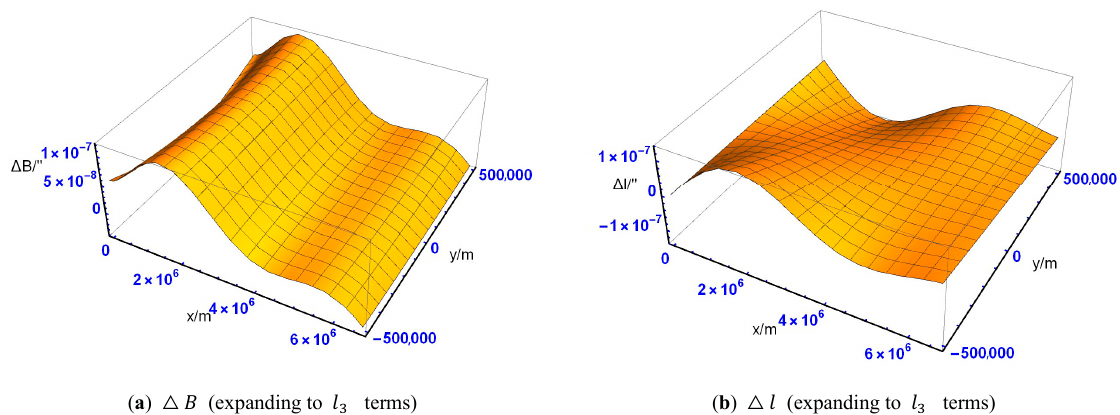
Figure 19. The distribution of ( ∆ B , ∆ l ) when expanding to l 3 terms (based on n ). To sum up, on the premise of meeting the accuracy requirements of geodesy, the simplified expressions of the complex functions of the three forms of the Gauss-Krüger projection are as